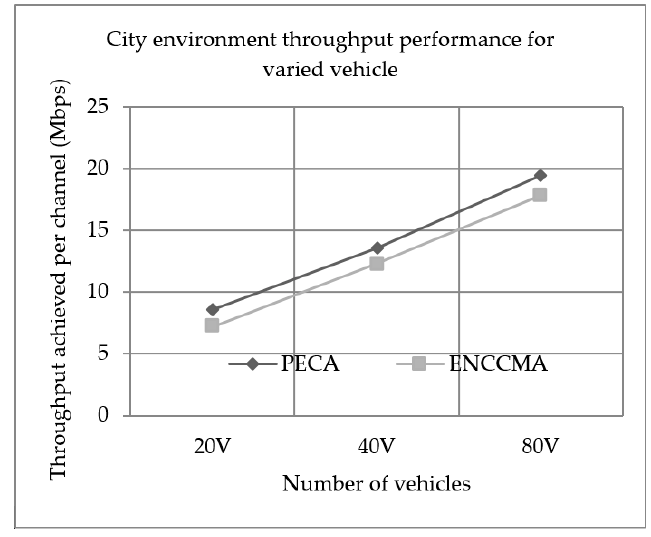
Figure 1. City environment throughput performance for varied vehicle.